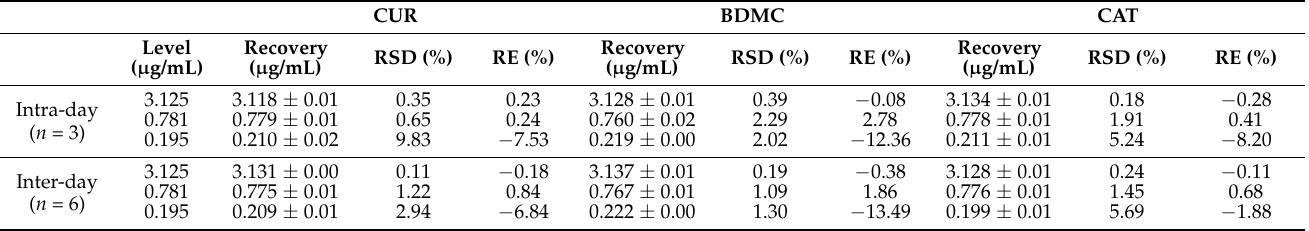
Table 3. Precision and accuracy of the HPLC method for the determination of curcuminoids. CUR BDMC